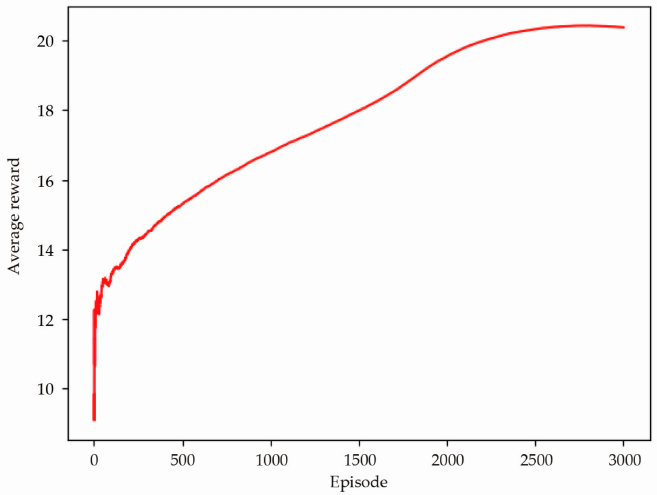
Figure 6. The trend of average reward increasing with